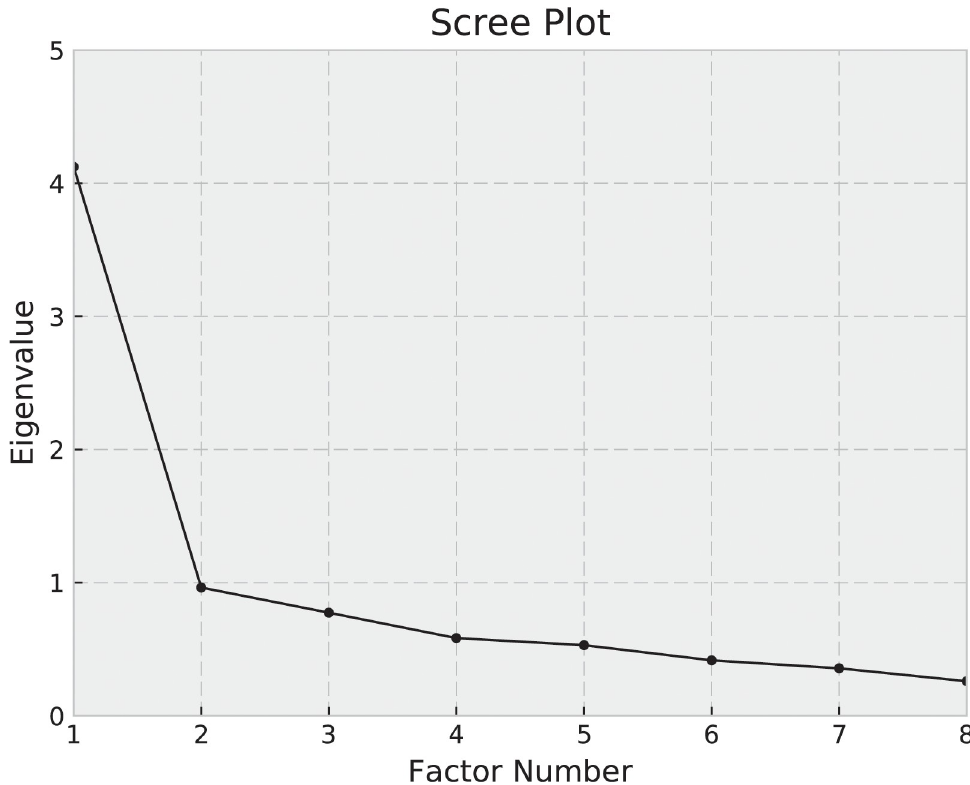
Fig 1. Scree plot of Lysholm score.